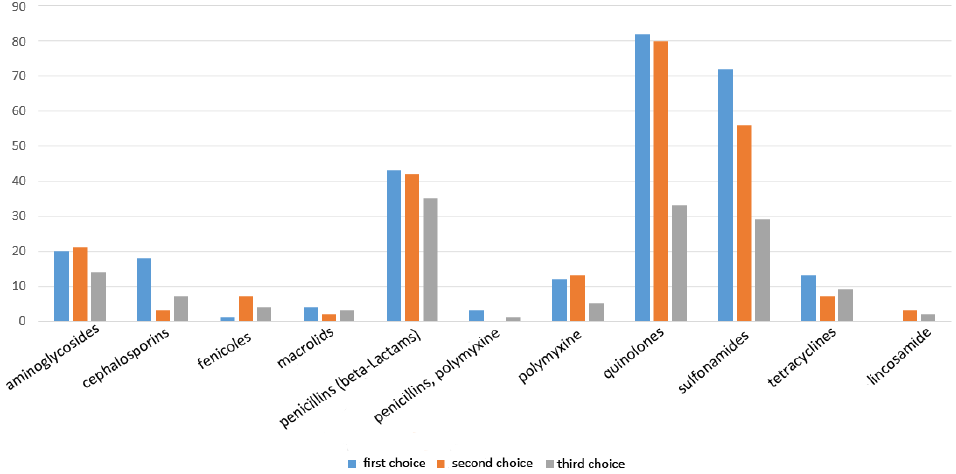
Figure 3. Use of antibiotic classes as first, second, or third choice. Table 2. Number of participants using oral and injectable antibiotics by occupation and